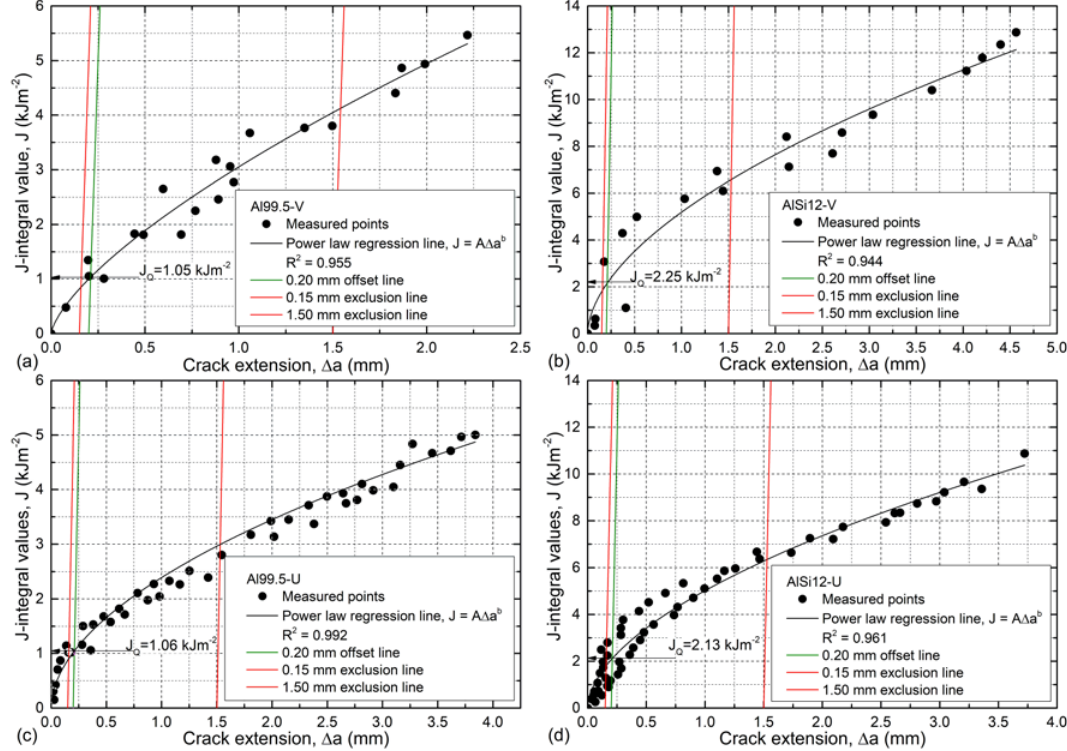
Figure 6. J–R curves of ( a ) Al99.5-V, ( b ) AlSi12-V, ( c ) Al99.5-U, and ( d ) AlSi12-U type MMSFs. The J–R curves plot the agglomerated data of all samples within one MMSF type. Power law